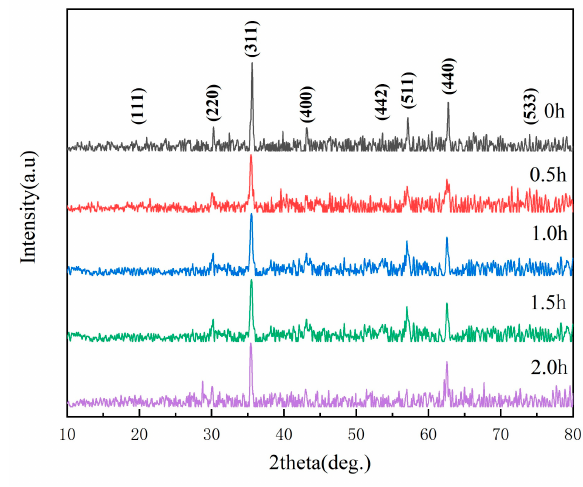
Figure 1. XRD spectra of Fe 3 O 4 samples at different milling times.